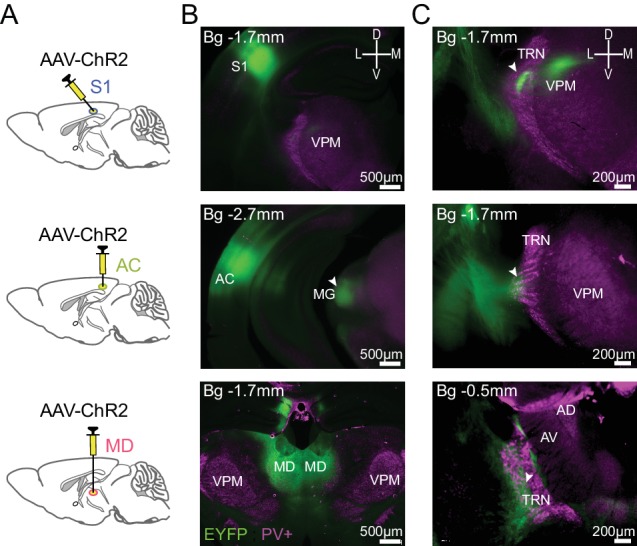
Identification of TRN sectors through anterograde tracing.(A) Scheme illustrating injection of AAV-ChR2_EYFP into S1 (top), AC (middle) and MD (bottom). (B) Epifluorescent micrographs of coronal sections at 2.5x magnification, anteroposterior position indicated with respect to bregma (Bg). ChR2-EYFP (green) expression in infected S1 neurons and their projection to TRN and VPM (top), in AC neurons and their projection to medial geniculate nucleus (MG) (middle) and in MD neurons (bottom), with immunostaining for PV-positive (PV+, magenta) TRN neurons. The VPM appears in light magenta due to its innervation by TRN. (C) Expanded view of the target TRN sector at 5x magnification. White arrowheads indicate sites of projection into TRN.